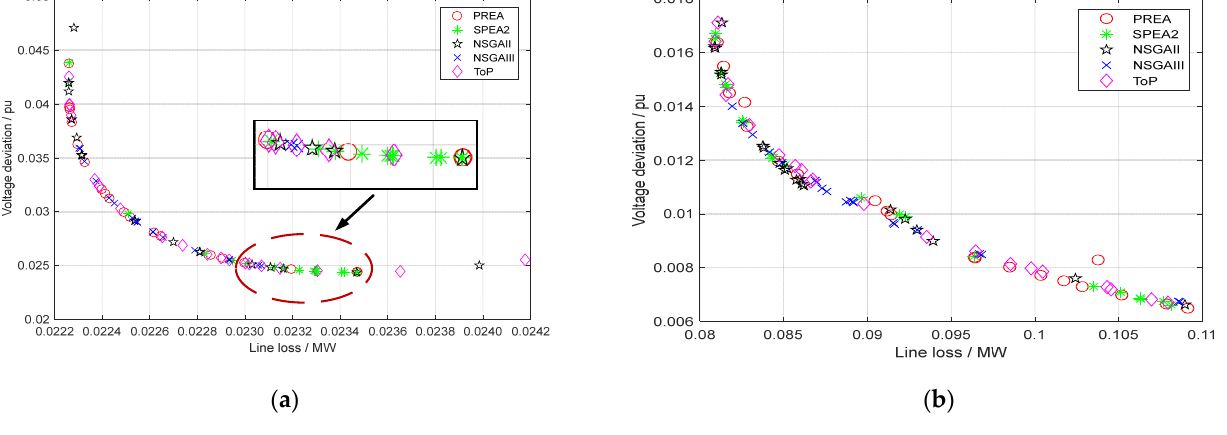
Figure 5. ( a ) PF comparison of different algorithms in IEEE 14-bus system; ( b ) PF comparison of different algorithms in IEEE 33-bus system.